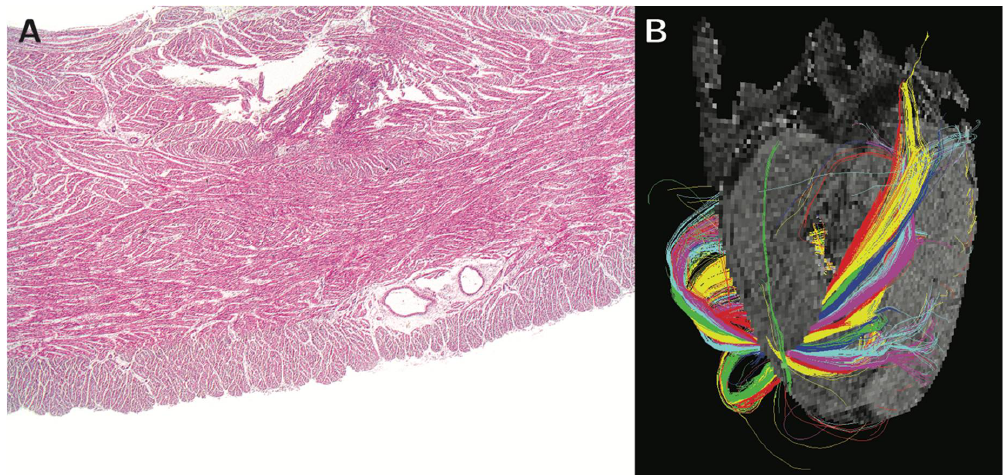
Figure 5. Panel ( A ) shows a histological section of the right ventricular wall of the sheep heart stained with hemotoxylin and eosin, revealing the heterogeneous mural architecture. The helical angle of the chains of cardiomyocytes aggregated together within the right ventricular walls is shown in panel ( B ), which is a tractograph generated from different zones of the walls. The color coding of the tractography does not represent any anatomical or physiological property. It serves only as a visual aid enabling the reader to distinguish between the tracks, and to visualize the mean orientation of cardiomyocytes within them. Modified from Agger et al., 2015 [48].